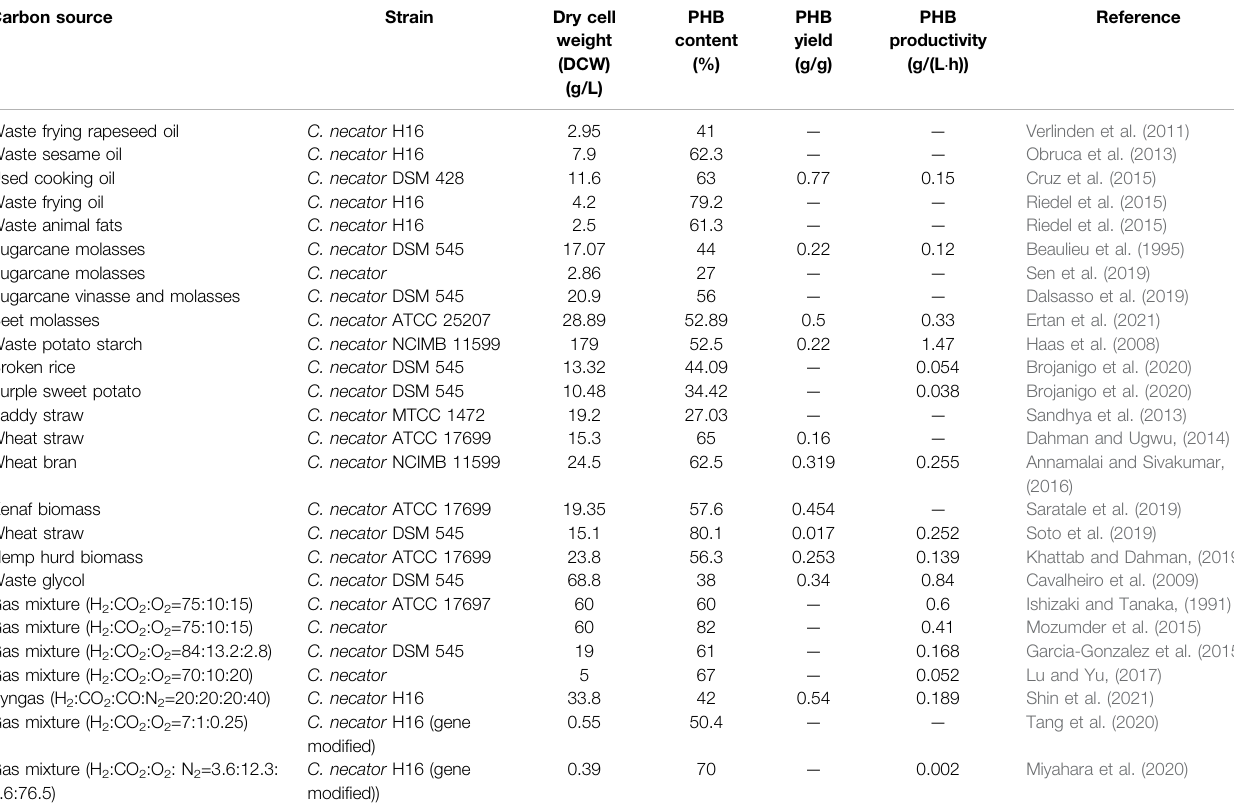
TABLE 1 | Summary of PHB Production using C. necator from different carbon sources. Carbon source